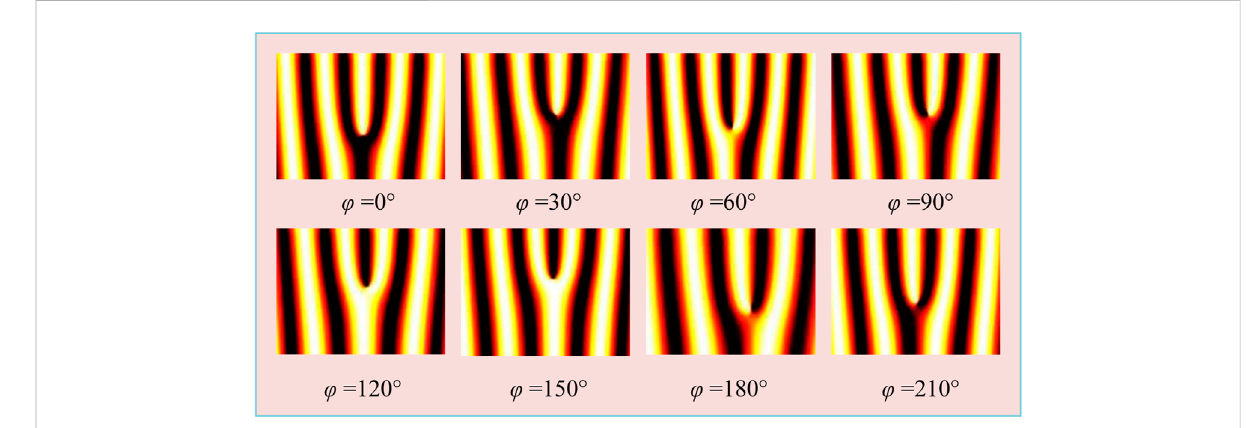
FIGURE 4 Interference patterns corresponding to different phase differences.